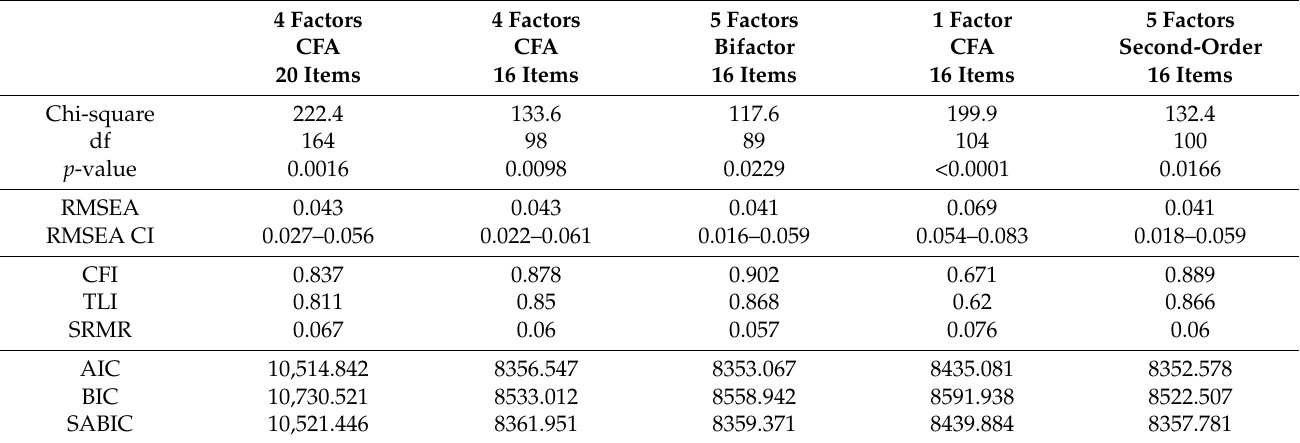
Table 3. Fit indices for the confirmatory factor models. Both the bifactor and the second-order factor models have 5 factors, which are the 4 specific factors and the general factor.